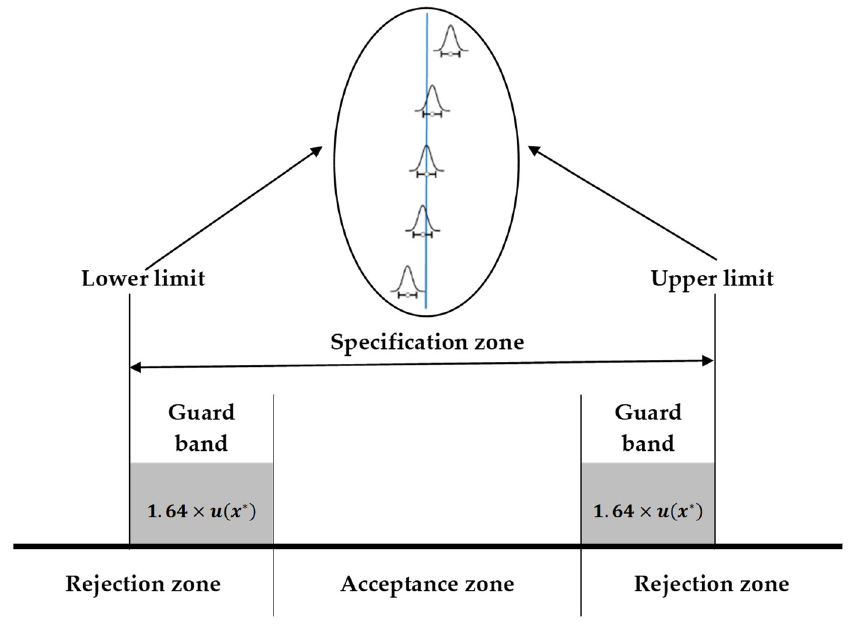
Figure 1. Acceptance and rejection zones for simultaneous upper and lower limits based on guard bands.